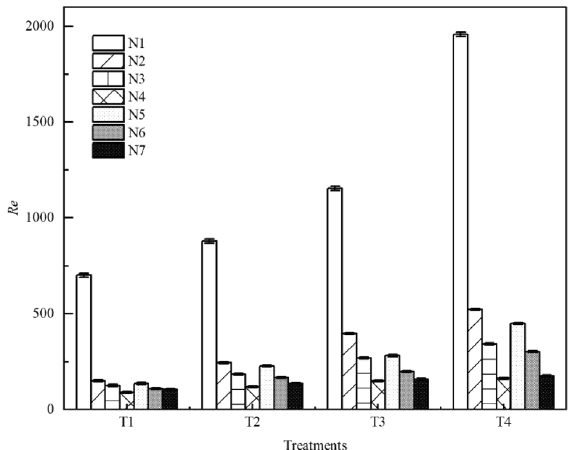
Figure 3. Comparison of the Reynolds number Re between seven types of litter layer. Re is the Reynolds number of the water flow; N1–N7 are treatments, see Table 2 for treatment specifics; T1 is slope 5°, rain intensity 60 mm·h −1 ; T2 is slope 10°, rain intensity 60 mm·h −1 ; T3 is slope 5°, rain intensity 120 mm·h −1 ; T4 is slope 10°, rain intensity 120 mm·h −1 . Error bars indicate standard